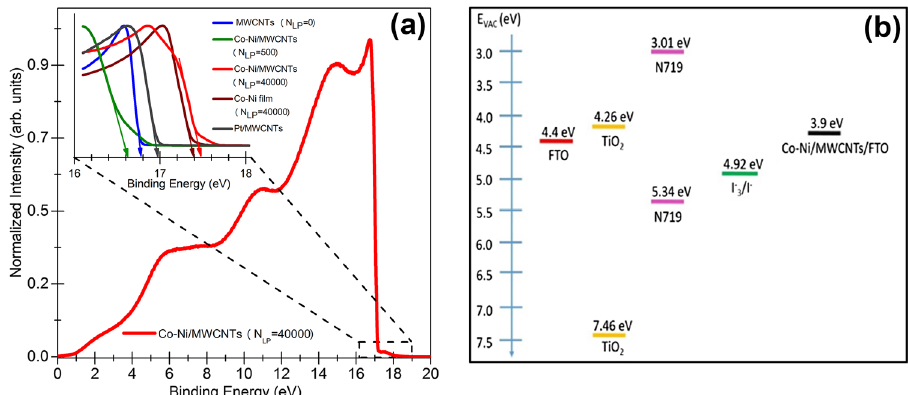
Fig. 4 a Typical UPS spectrum of MWCNTs decorated with a Co–Ni NPs layer at N LP = 40,000. The inset compares the zoomed-in secondary electron cut-off region of the UPS spectra for